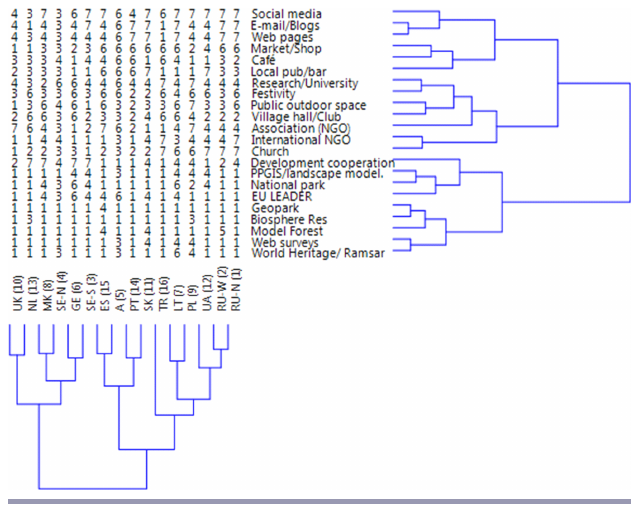
Fig. 6 . Hierarchical clustering using Ward’s method and Euclidian similarity index for 16 hotspot landscapes based on estimates of the types of traditional, novel, and virtual fora in each of them. Data derived from Table 2. PPGIS = Public Participation Geographic Information